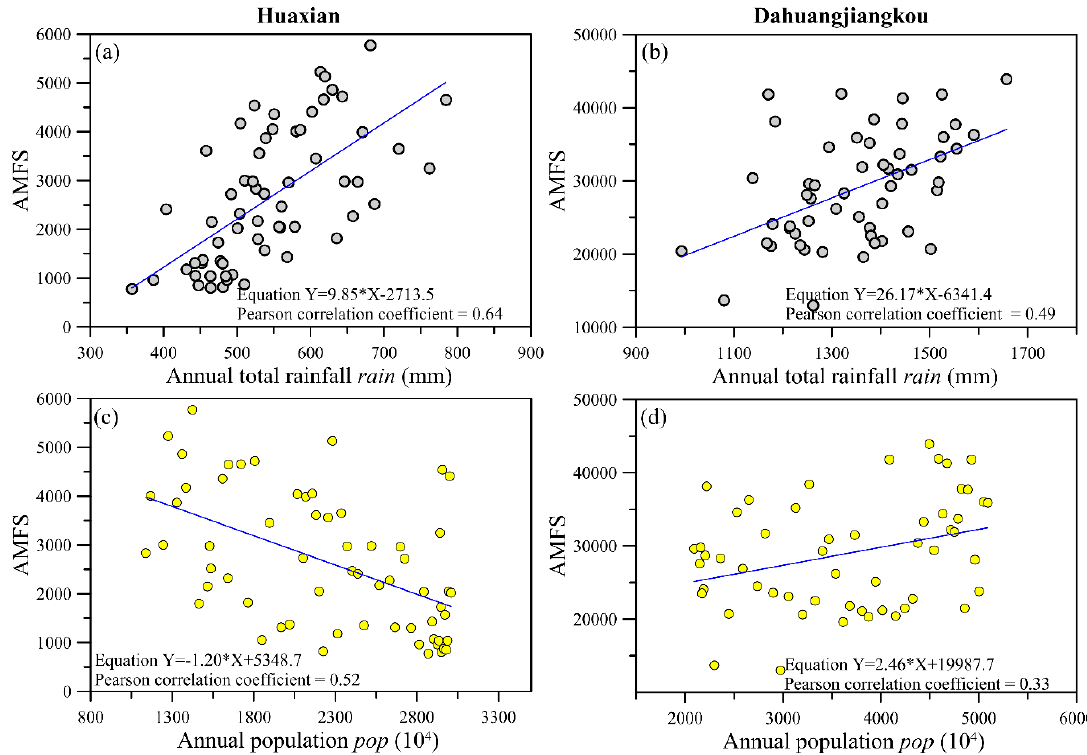
Figure 4. Correlations between annual maximum flood series (AMFS) and rain ( a , b ) or pop ( c , d ) for Huaxian and Dahuangjiangkou stations.